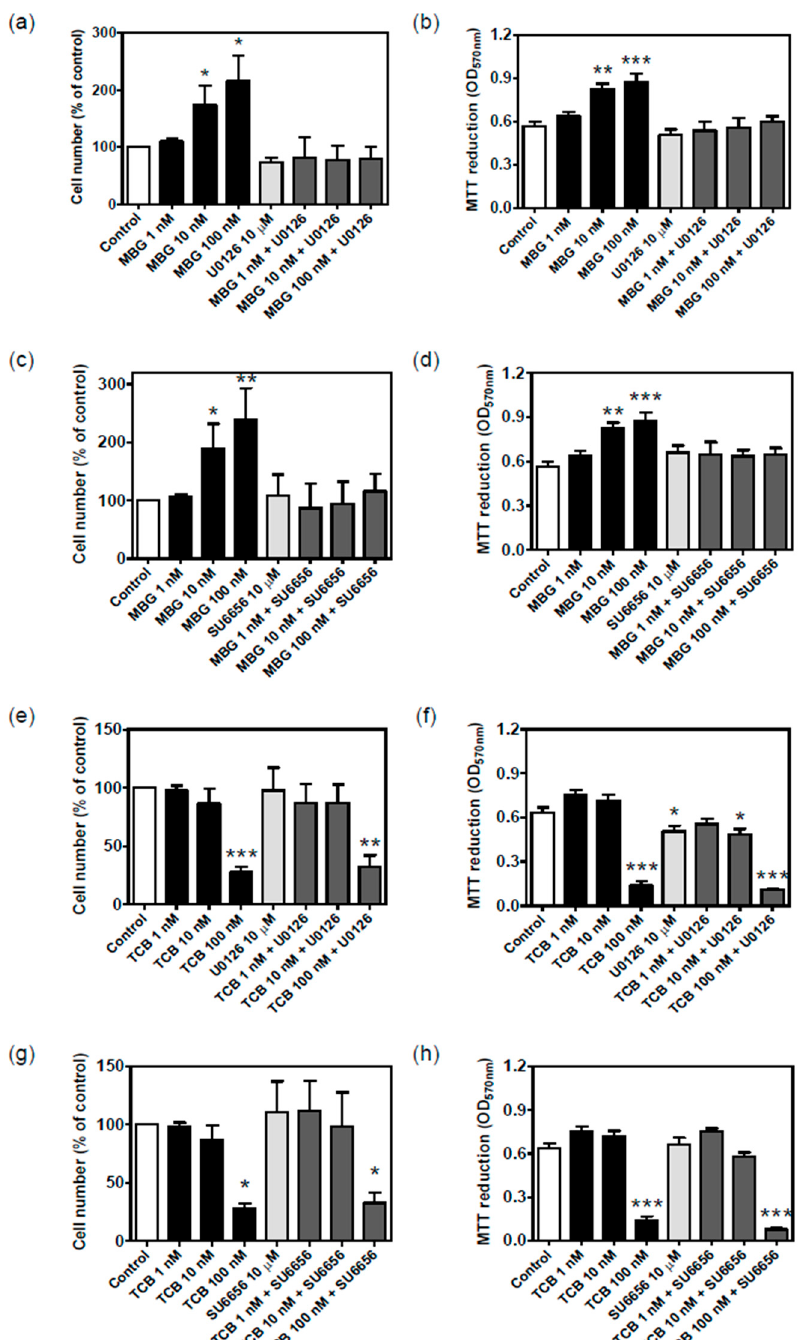
Figure 10. Effect of MEK1/2 and Src inhibition on cell proliferation and viability of LLC-PK1 cells treated with marinobufagin (MBG) and telocinobufagin (TCB). Serum-starved LLC-PK1 cells were treated with 1, 10, and 100 nM MBG ( a – d ) and TCB ( e – h ) in 2.5% FBS for 72 h with or without 10 µ M U0126 (MEK inhibitor) ( a , b , e , f ) or 10 µ M SU6656 (Src inhibitor) ( c , d , g , h ). Trypan blue-free viable cells were counted in Neubauer chamber ( a , c , e , g ) and viability was assessed by MTT ( b , d , f , h ). Data are the mean ± SEM of at least three independent experiments in duplicate. * p < 0.05; ** p < 0.01; *** p < 0.005 vs. control.